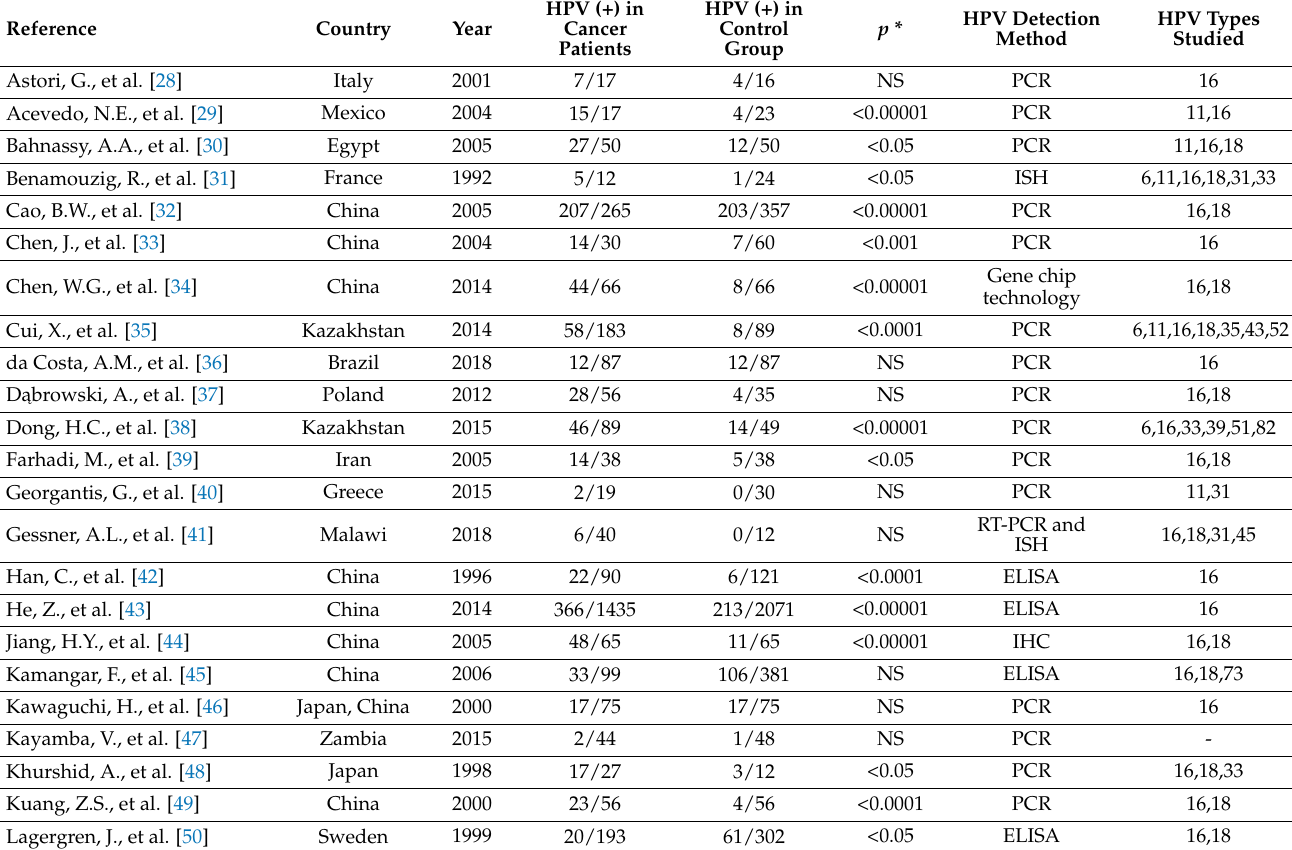
Table 3. Summary of the studies on the human papillomavirus in esophageal